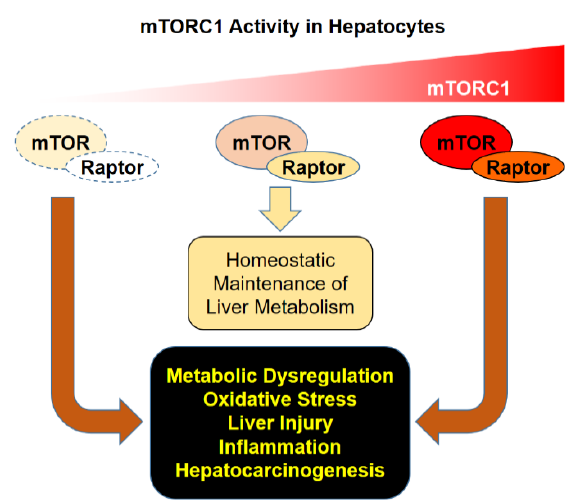
Figure 2. Consequences of mTORC1 dysregulation. Proper regulation of mTORC1 activity is critical for homeostatic maintenance of liver metabolism. Hypo- or hyper-activation of mTORC1 can provoke metabolic dysregulation and oxidative stress, which can lead to hepatocyte injury, inflammation, and subsequent hepatocarcinogenesis.